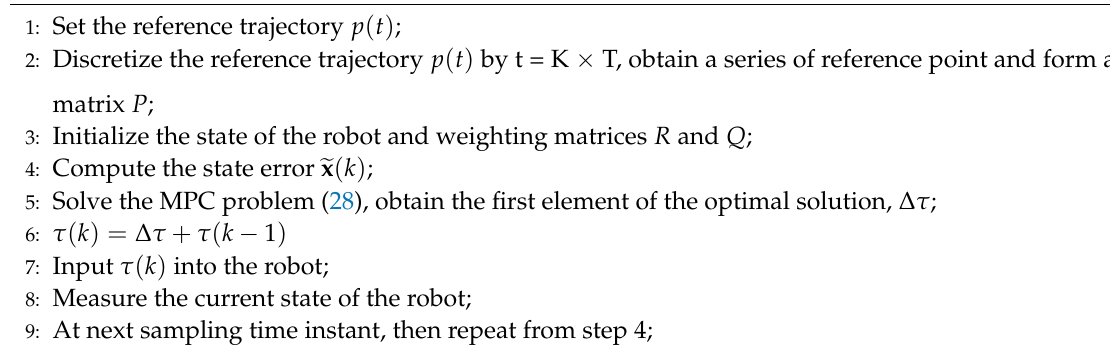
Algorithm 1 MPC-based trajectory tracking control